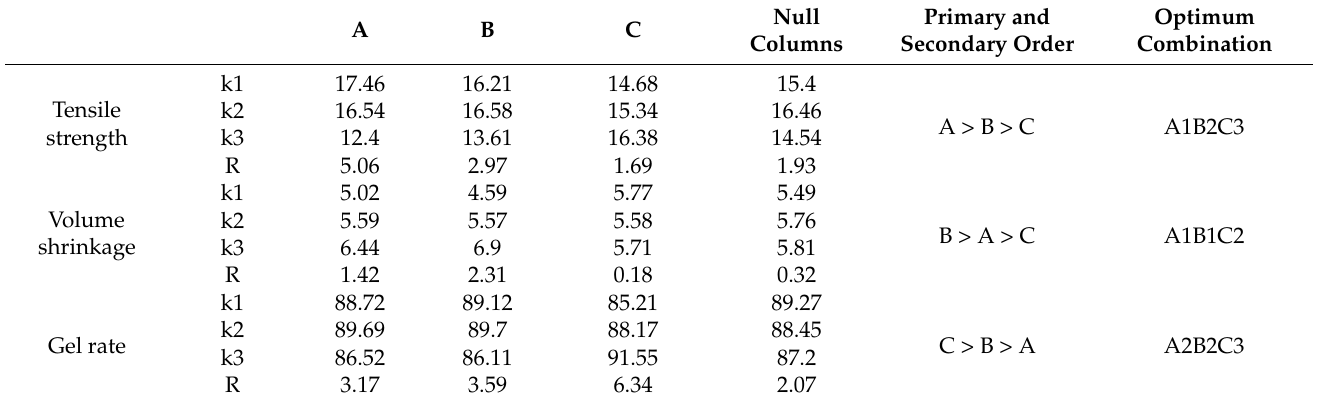
Table 4. Range analysis results.